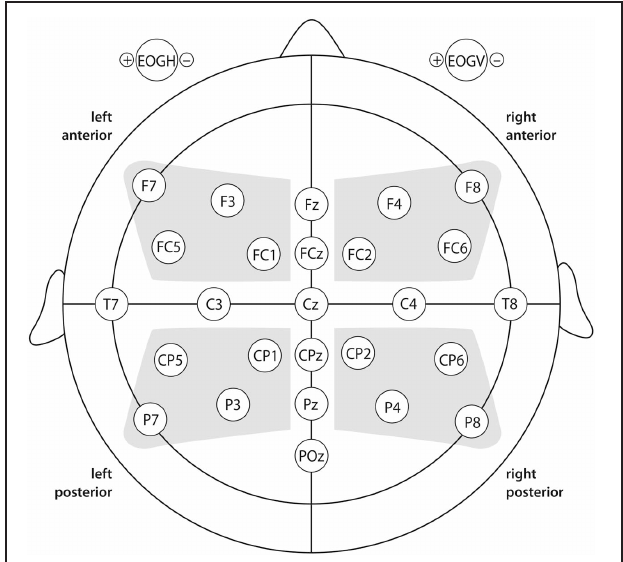
FIGURE 1 | A top view of the scalp (up = forward; left = left). Additional electrodes labeled as “EOGH” and “EOGV” refer to the electrodes that record the horizontal and vertical electrooculogram. Statistical analysis involved the topographical factor “region of interest” (ROI). Lateral regions of interest are indicated by shaded areas: left-anterior (F3/F7/FC1/FC5); left-posterior (CP1/CP5/P3/P7); right-anterior (F4/F8/FC2/FC6); and right-posterior (CP2/CP6/P4/P8). For midline sites, each electrode was defined as a ROI of its own (FZ/FCZ/CZ/CPZ/PZ/POZ).